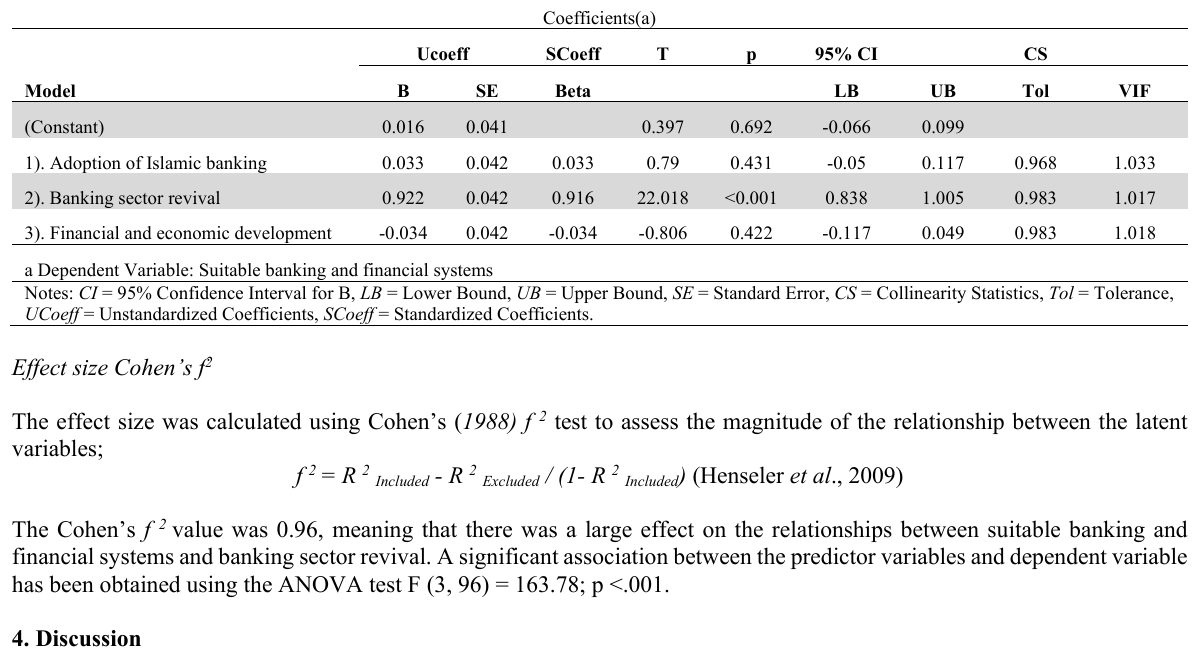
Linear Regression Unstandardized Coefficients and